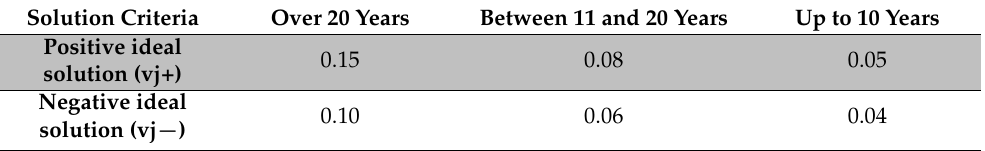
Table 8. Positive ideal solution and negative ideal solution for access to